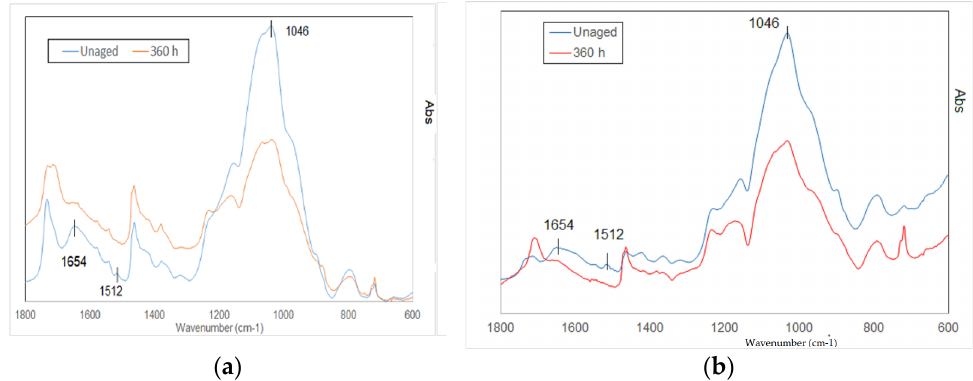
Figure 11. ATR FTIR spectra of unaged and UV (360 h) aged natural ( a ) and treated ( b ) samples.